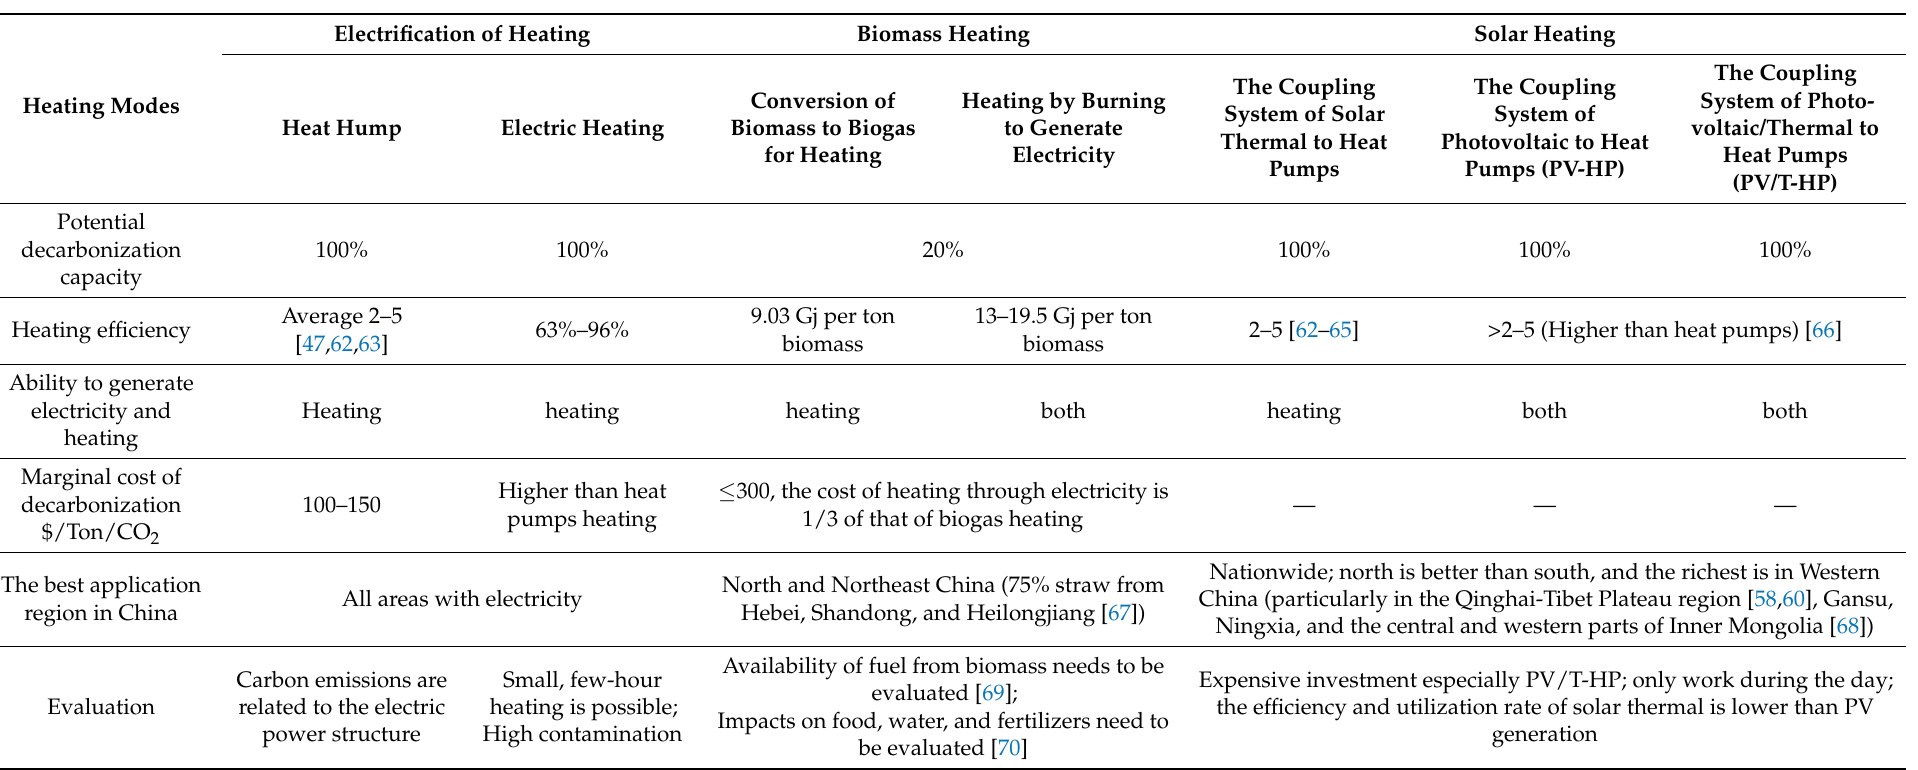
Table 3. Evaluation of common clean heating